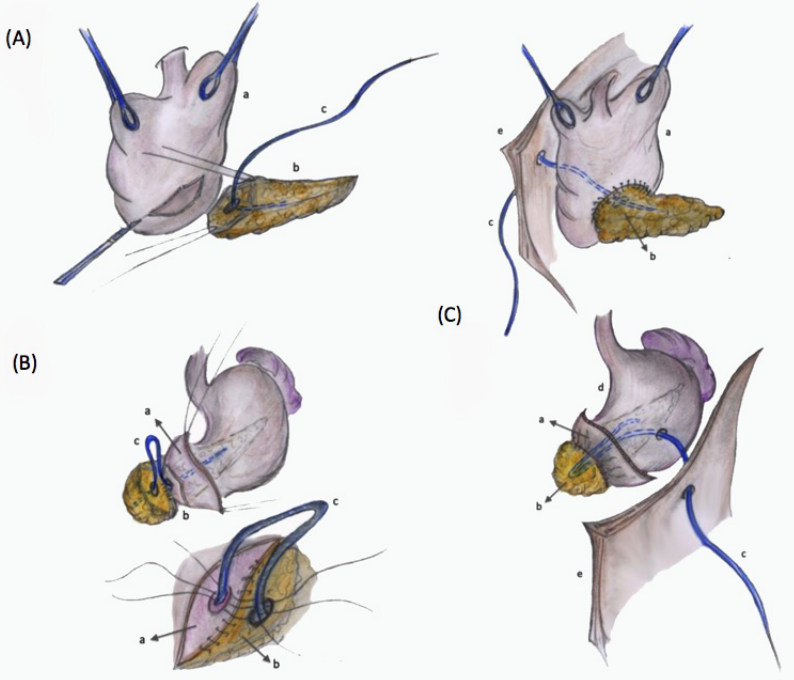
Figure 1. ( A ) The seromuscular incision on the posterior gastric wall (a) is slightly larger than the greatest diameter of the pancreatic stump (b). The catheter used as external stent (c) is introduced into the Wirsung duct to ensure its patency during anastomosis ( B ) The suture between the anterior pancreatic surface and the gastric seromuscular layer is performed. Then, the duct-to-mucosa anastomosis is performed, applying one or more stitches in each quadrant ( C ) After the anastomosis between the posterior gastric wall and the pancreatic stump is completed, the catheter is secured to the anterior gastric seromuscular layer (d) and exteriorized through the anterior abdominal wall (e). Finally, the gastric seromuscular layer was sutured to the posterior pancreatic